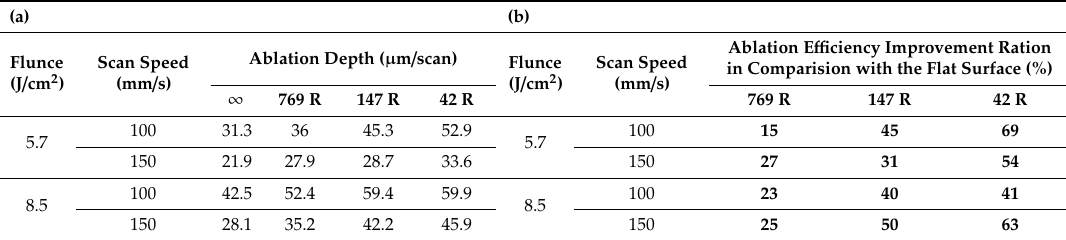
Table 1. Comparison of ablation depth ( a ) and ablation e ffi ciency improvement ratio in comparison with the flat surface ( b ) after five scans under various conditions between the conventional laser ablation and the preliminary